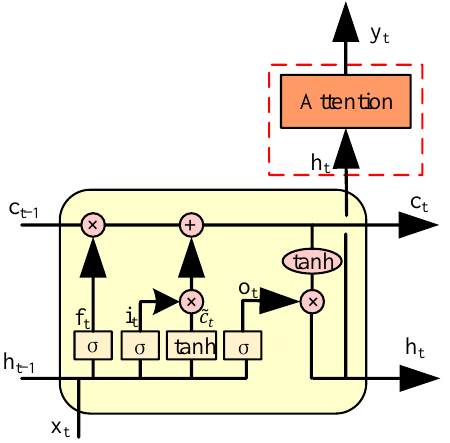
Figure 4. Diagram of the LSTM attention